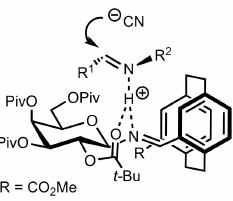
Figure 31. The proposed mechanism for the ( S )-stereoselective formation of α -amino-nitriles.